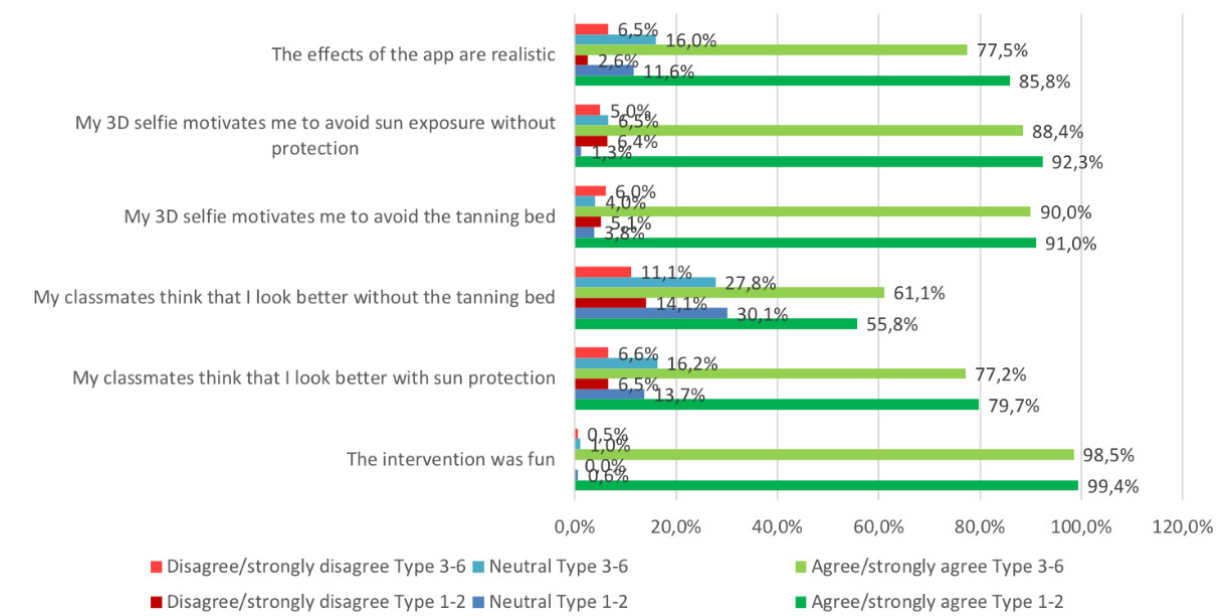
Figure 8. Results in Fitzpatrick skin types 1-2 versus 3-6. 3D: